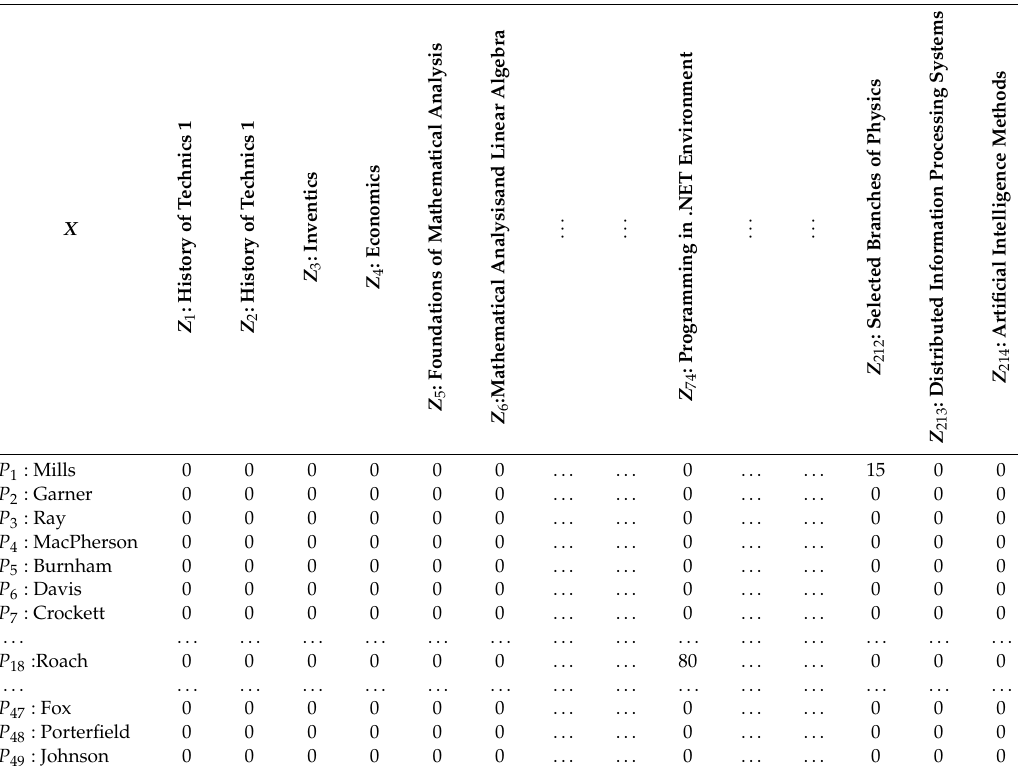
Table 8. Teacher allocation, X , of the teaching sta ff employed by FECS (source: https: // github.com / erykszw /